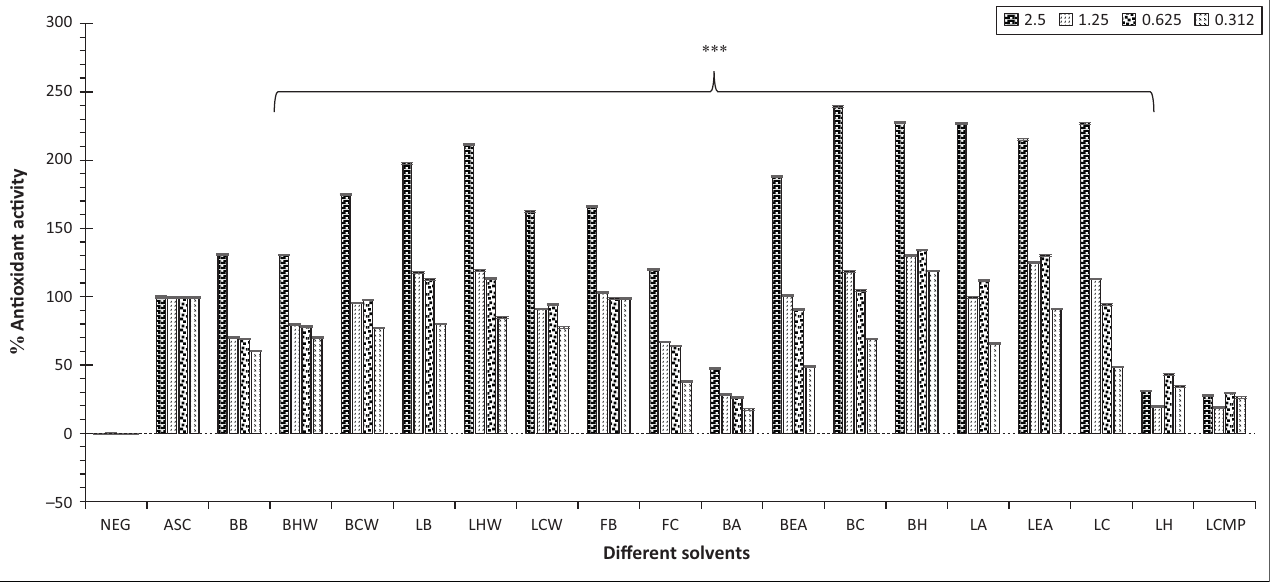
FIGURE 2: Antioxidant (radical scavenging) activity using diphenyl-1-picrylhydrazyl assay on bark, fruits and leaf extracts of C. grandicalyx .